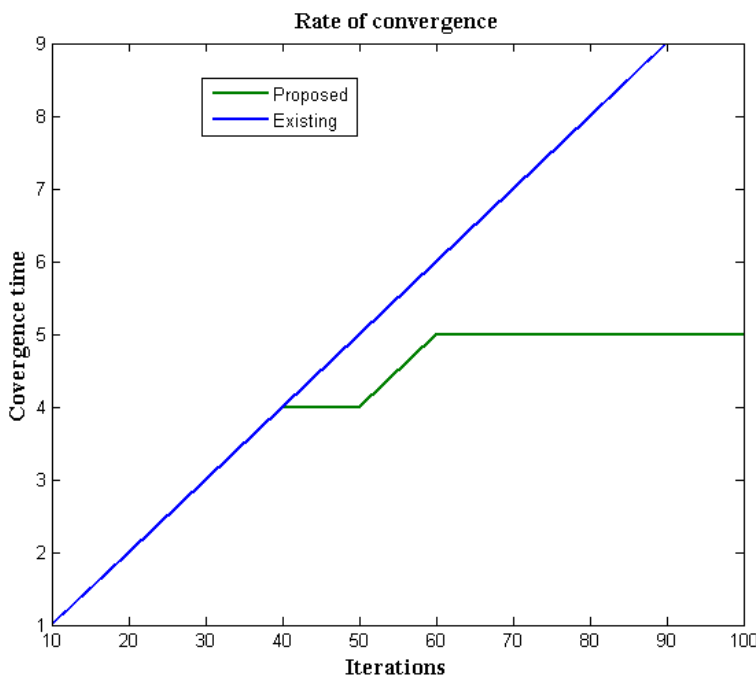
Figure 8. Convergence characteristics.